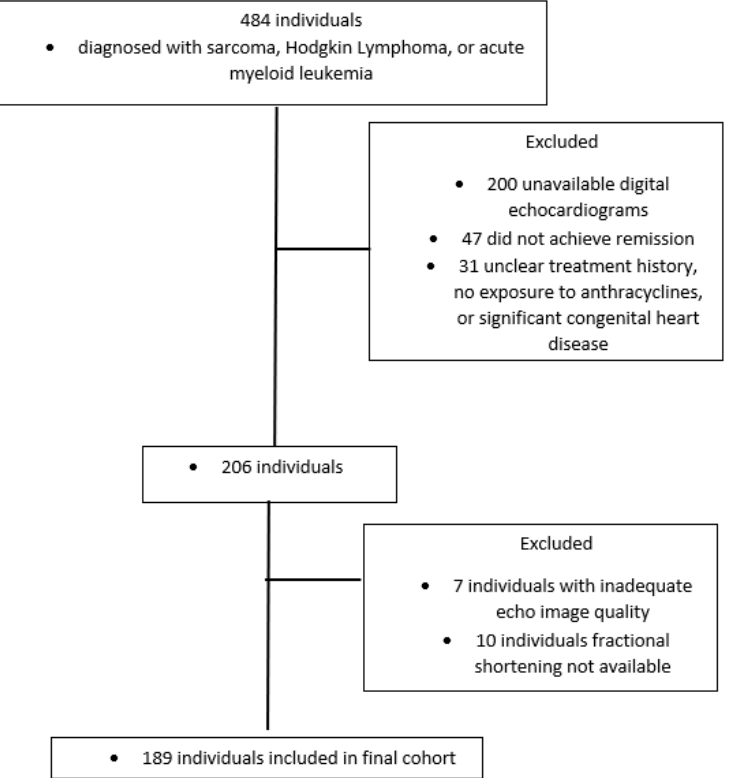
Figure 1. A total of 189 subjects were included in the study. The most common reasons for exclusion were unavailable digital echocardiograms (72%) and remission was not achieved (17%).